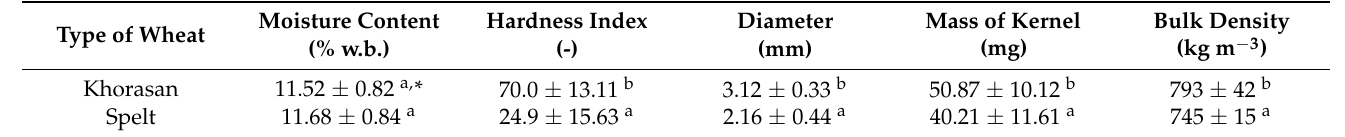
Table 1. Initial moisture content and physical properties of the tested